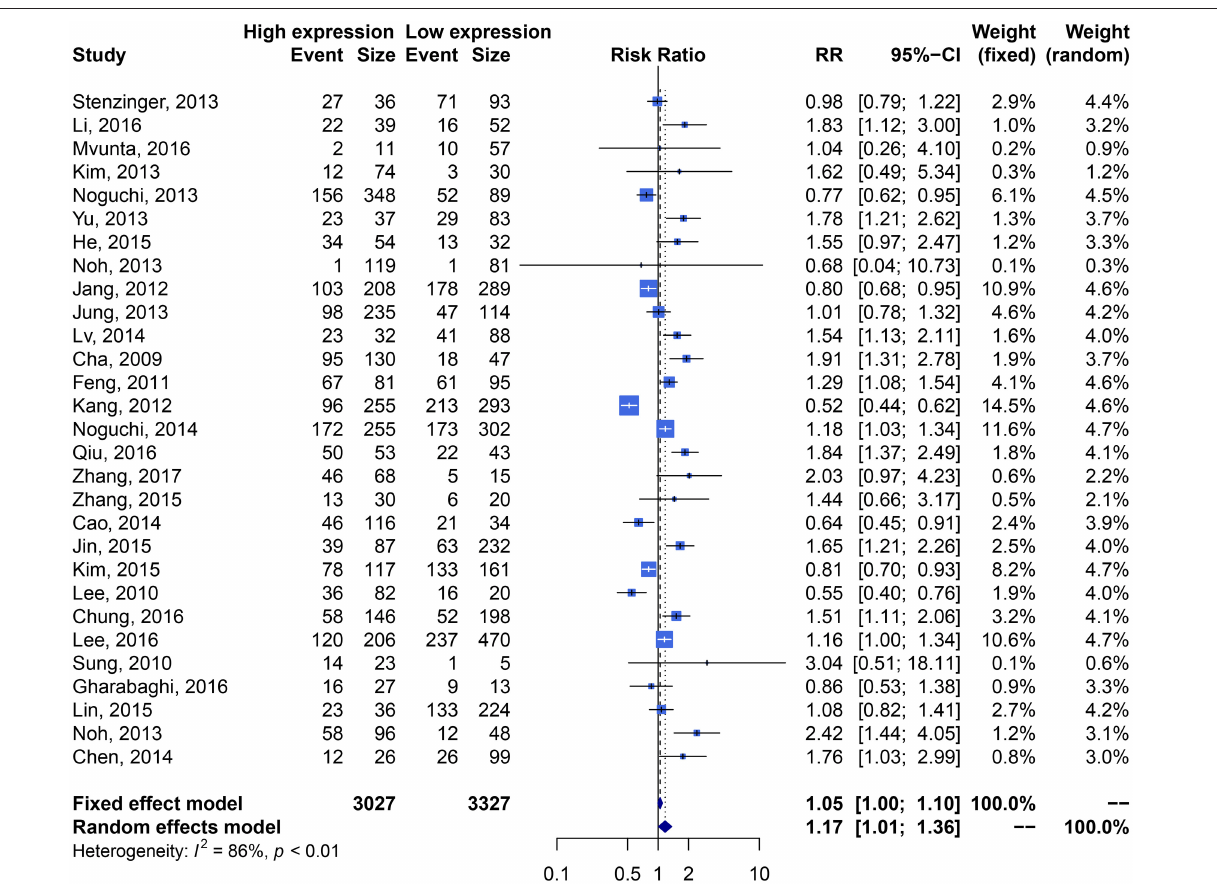
FIGURE 5 | Forest plots of lymphatic metastasis compared SIRT1 overexpression with underexpression.